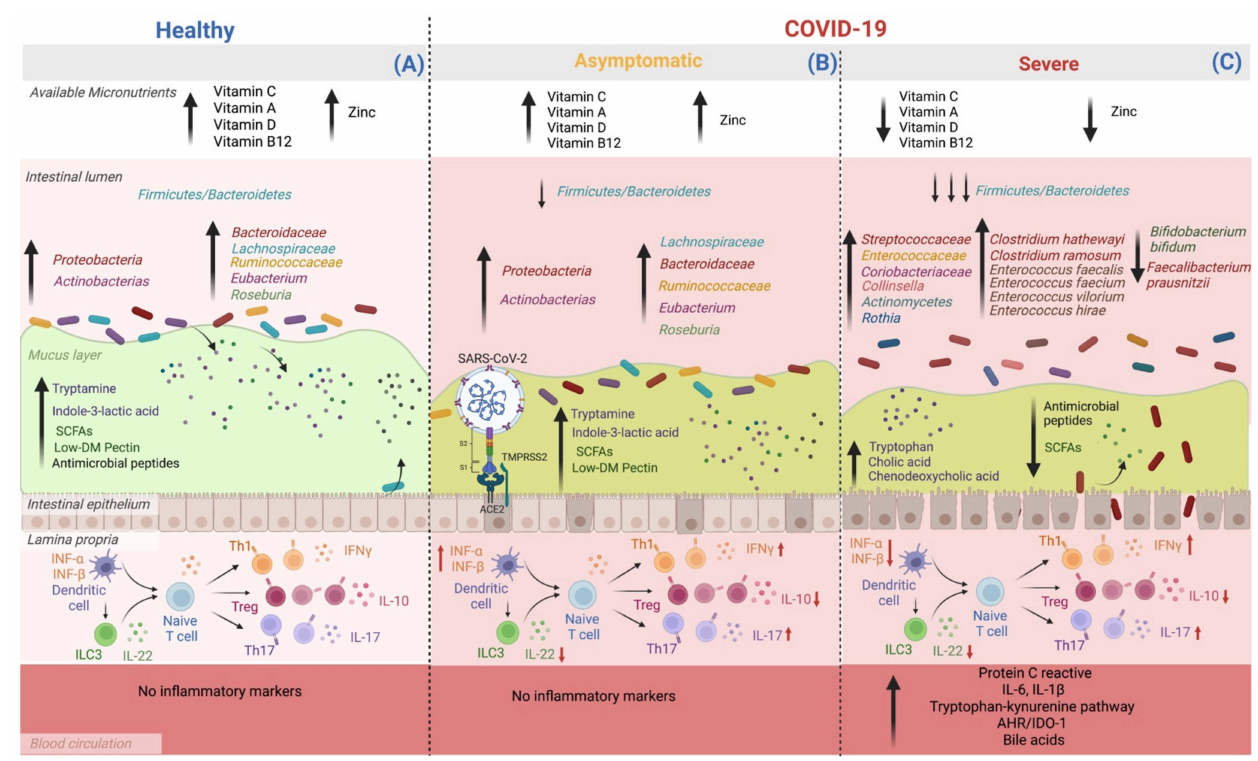
Figure 2. Micronutrient availability, gut microbiota, and its derived metabolites modifications according to COVID-19 severity. Patients with severe complications from COVID-19 have lower availability of micronutrients such as vitamin C, A, D, B12, and Zn compared to asymptomatic and healthy subjects. On the other hand, the dysbiosis of GM seems to worsen as the complications of the disease progress. ( A ) Healthy subjects have an adequate balance in the Firmicutes: Bacteroidetes ratio, as well as an abundance of beneficial species belonging to the Proteobacteria and Actinobacteria phyla, such as Lachnospiraceae , Bacteroidaceae , Ruminococcaceae , Eubacterium , and Roseburia . Therefore, there is an adequate production of metabolites from the processing of host nutrients: SCFAs, secondary BA, tryptamine, and indole-3-lactic acid. Additionally, some molecules that regulate immune cell function are present, including the balance between Th cell subtypes and their role in controlling a tolerogenic environment and the intestinal barrier. ( B ) In asymptomatic people with COVID-19, no micronutrient deficiency is observed; in addition, although there is an alteration in the GM when compared to uninfected individuals, it is not as marked; the Firmicutes–Bacteroidetes ratio decreases, mainly affecting immunological regulation since there is a decrease in the production of IL-22 and IL-10. Also, an increase in IFN γ IL-17, the latter cytokines are necessary for the antiviral response. ( C ) In patients with severe COVID-19, there is a deficiency of vitamins C, A, D, B12, and Zn. In addition, the ratio of Firmicutes–Bacteroidetes decreases significantly, the abundance of pathogenic bacteria increases, and those beneficial in pathways decrease nutrient metabolism, which reduces beneficial host metabolites synthesis, such as SCFAs and tryptophan-derived metabolites synthesized by bacteria, such as tryptamine and indole-3-lactic acid. This set of events, together with the intrinsic failure of intestinal transit, also causes the accumulation of primary BA in the colon and an increase in the circulation of primary and secondary BA. Therefore, it increases the damage to the intestinal barrier and bacterial translocation, which leads to a proinflammatory environment with high serum levels of C-reactive protein, IL-6 and IL-1 β , proinflammatory cytokines that promote the continuous activation of AHR-IDO-1 and reduces the antiviral response of INF type 1 ( α and β ) (created by